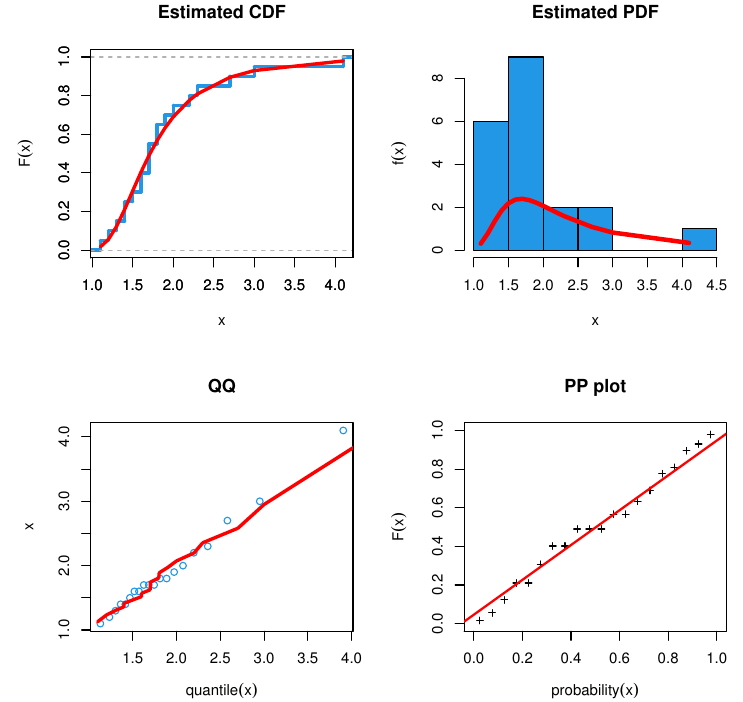
Figure 13. Estimated pdf, estimated cdf, PP and QQ plots for FB distribution for third dataset.